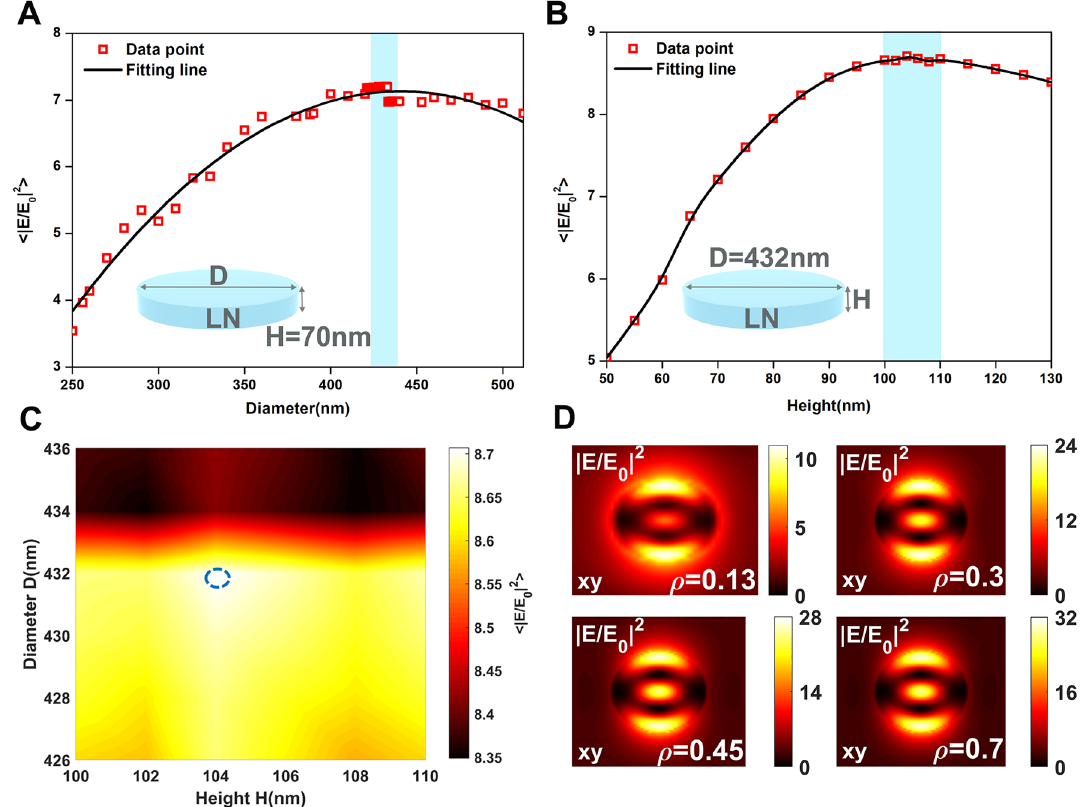
Figure 4: Numerical analyses of the LN-nanodisk geometries and the field distributions of different HMM filling fraction of the metal. (Color online) (A) Normalized maximum electric field intensity enhancement of varying the height of LN nanodisk, while diameter is fixed to 432 nm. The coarse optimal D is around 432 nm. (B) Normalized electric fi eld intensity enhancement of varying the diameter of LN nanodisk, while height is fi xed to 70 nm. The coarse optimal H is around 104 nm. The data points are fi tted. (C) Fine optimization of LN nanodisk geometries aroundthevicinityof coarseoptimalone( D =432 nm, H =104 nm)andtheoptimaloneisdepictedbythedashedbluecirclecorrespondingto parametersof D =432 nm, H =104 nm.(D)Normalizedelectrical fi eldintensityenhancementdistributions | E / E 0 | 2 forthedifferentHMM fi lling fraction of the metal ( ρ ) at ρ (cid:1) 0 . 13 (at wavelength of 595.2 nm), 0.3 (at wavelength of 573.9 nm), 0.45 (at wavelength of 569.7 nm) and 0.7 (at wavelength of 565.4 nm),